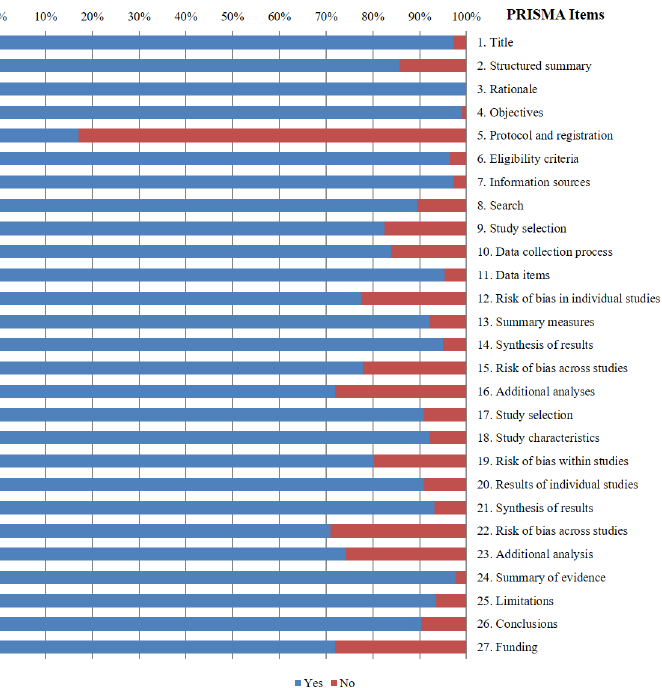
Fig 2. Individual items of and adherence to the PRISMA checklist. A higher percentage indicates a better adherence. “ Yes ” means that the item is fulfilled; “ No ” means that the item is not fulfilled or unavailable.